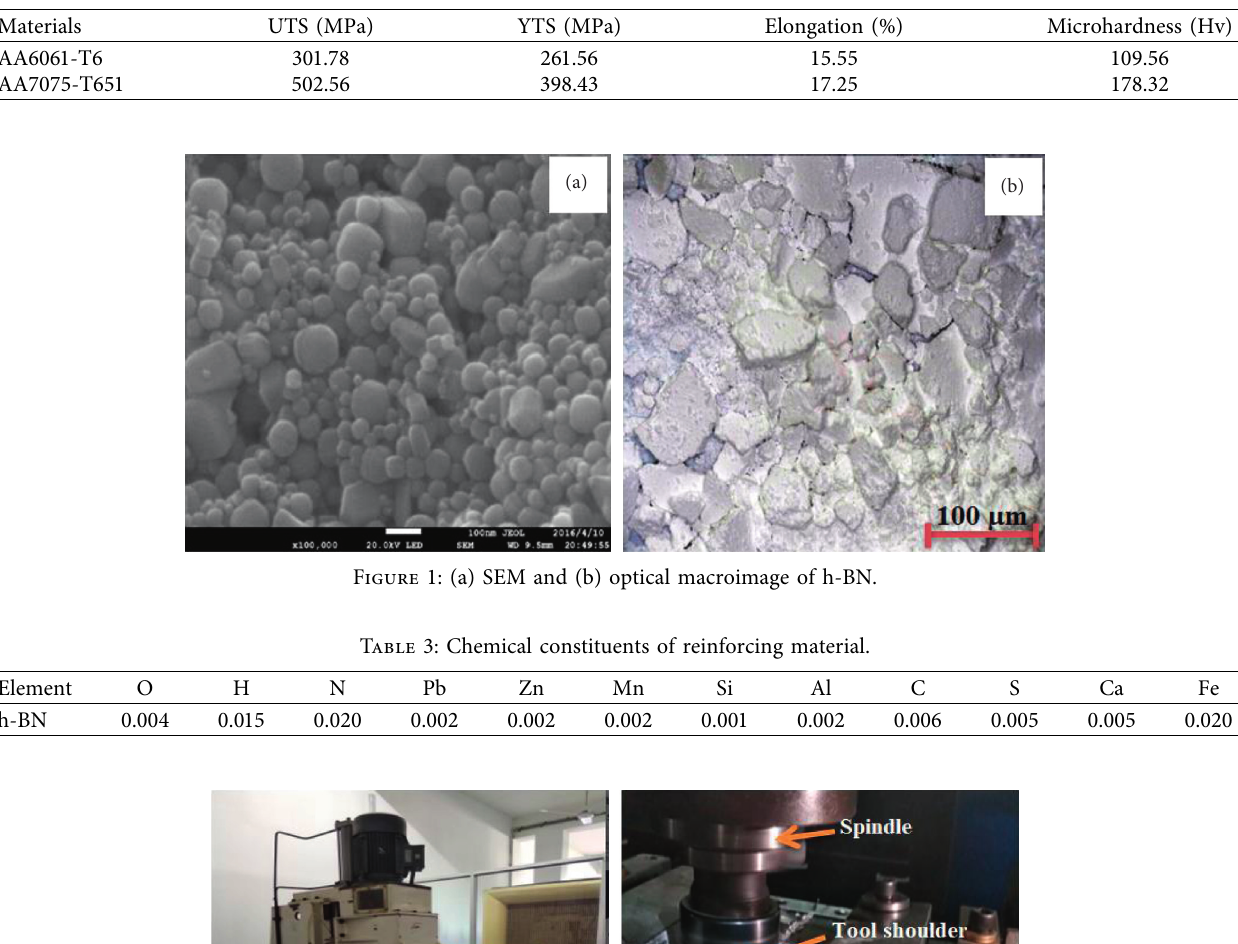
Table 2: Mechanical properties of chosen base materials.